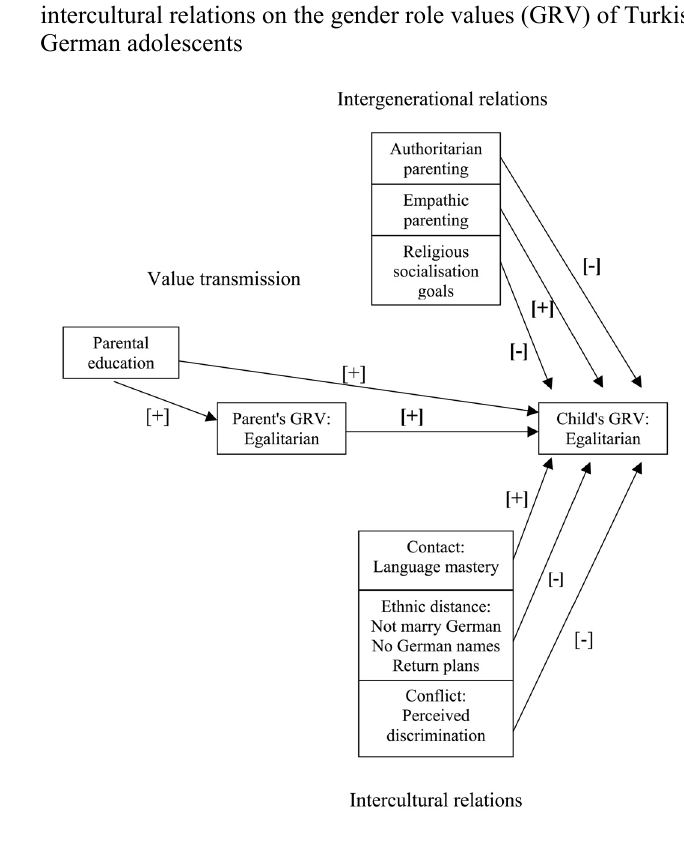
Figure 1. Hypothetical model: Expected effects of intergenerational and intercultural relations on the gender role values (GRV) of Turkish- German